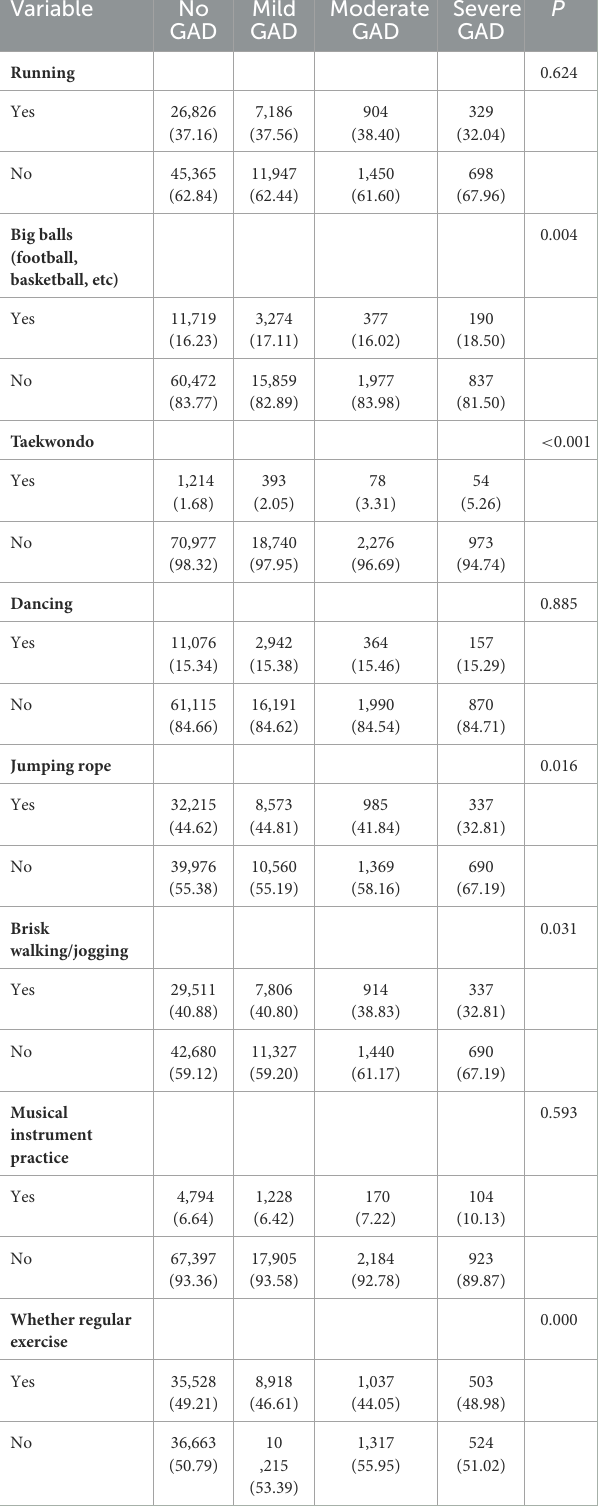
TABLE 5 The influence of children’s sports status on parents’ anxiety. TABLE 6 The logistic regression analysis of the influencing factors of